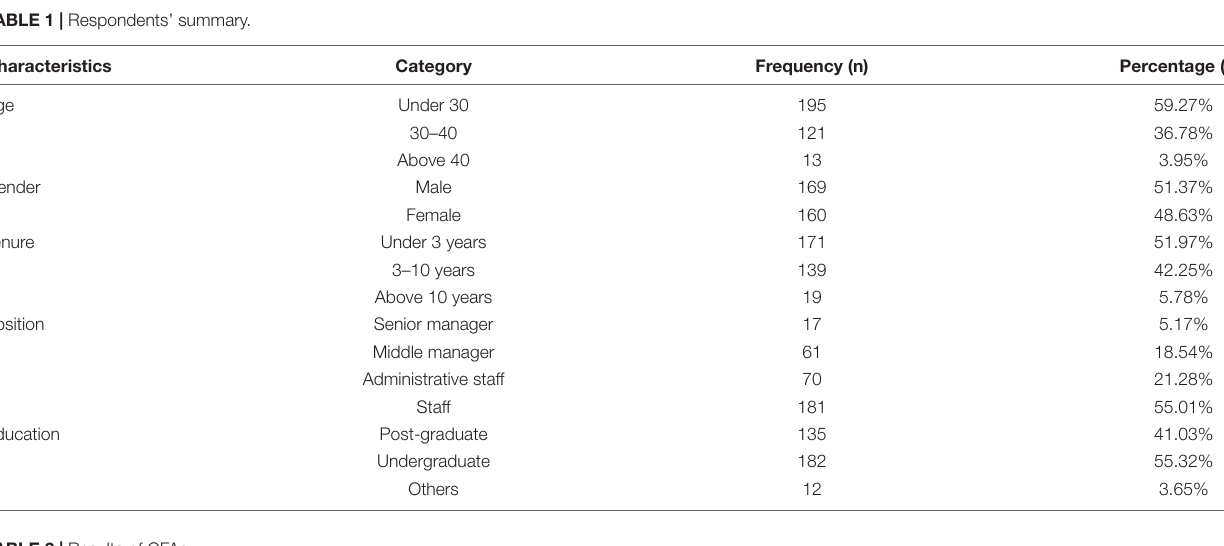
TABLE 2 | Results of CFAs.